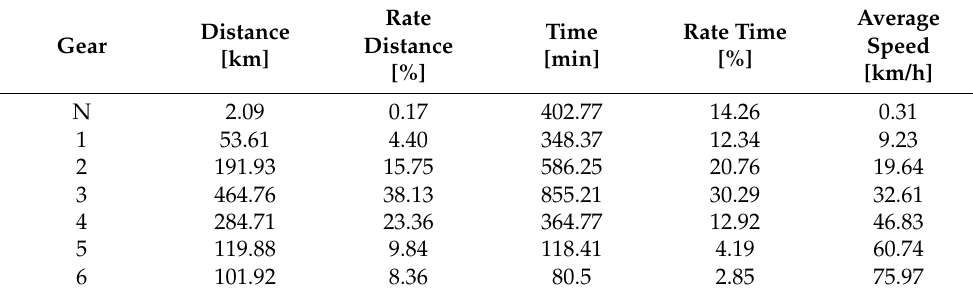
Table 4. Real driving conditions results.